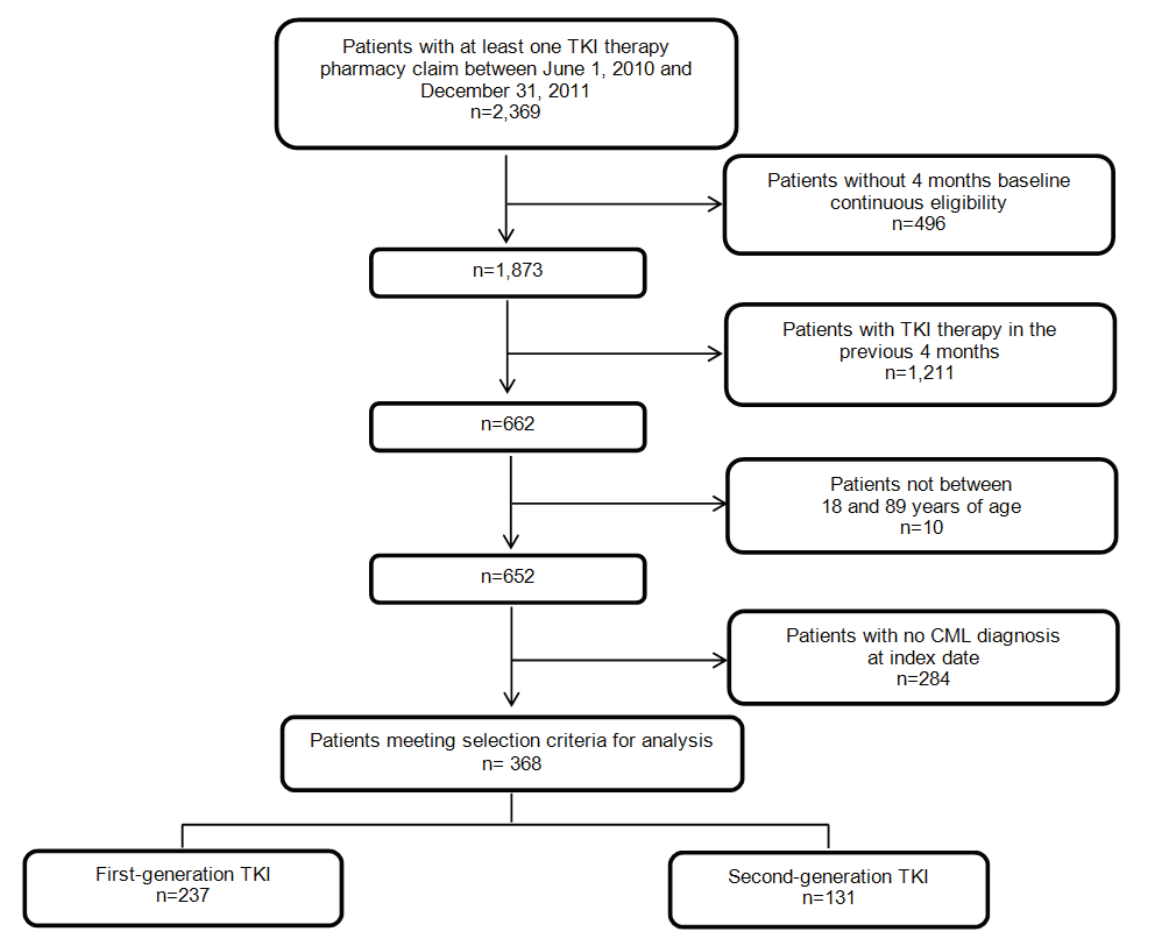
Figure 2. Sample